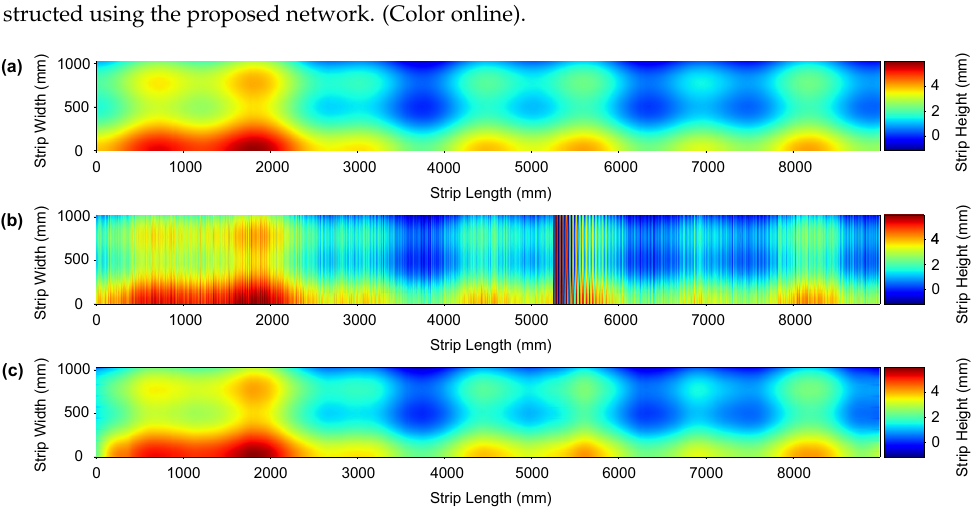
Figure 9. An instance of the denoising result on a synthetic strip. ( a ) Depicts the noise-free ground truth surface, ( b ) shows the noise corrupted surface, and ( c ) represents the denoised surface recon- structed using the proposed network. (Color